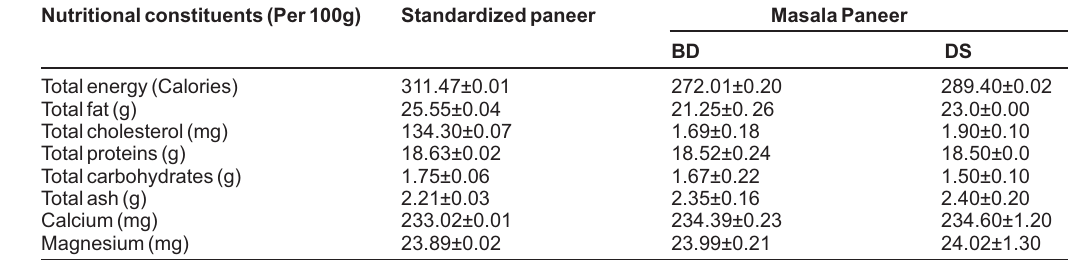
Table-1: Nutritional composition of ready-to-serve low cholesterol masala paneer products Nutritionalconstituents(Per100g)